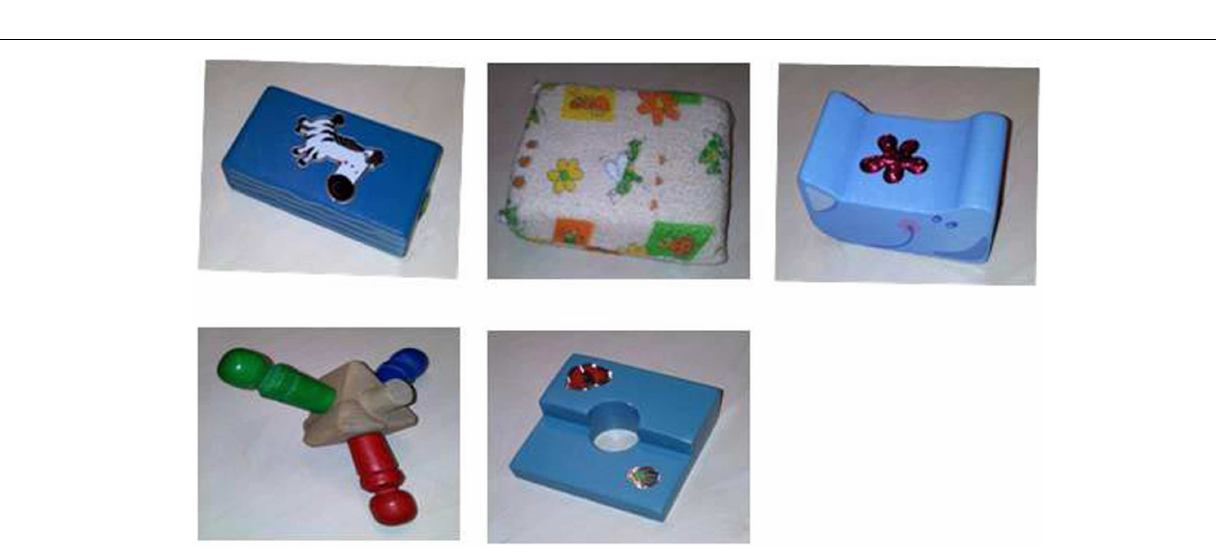
FIGURE 3 | Stimuli presented in the manual object exploration